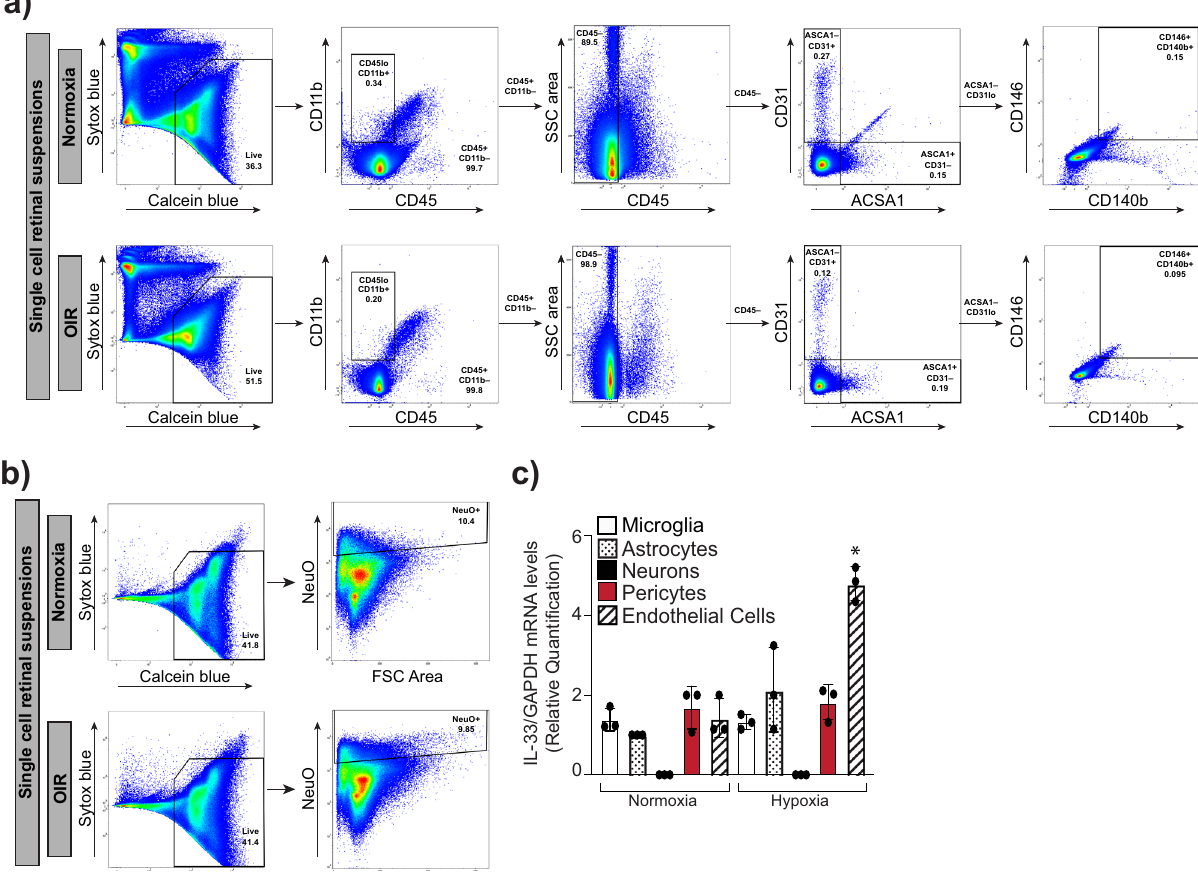
Fig. 4 Hypoxia-induced expression of IL-33 is mostly con fi ned to retinal endothelial cells. C57BL/6 mice pups were exposed to OIR and at P15 eyes from pups in normoxia or OIR were enucleated, retinas isolated, minced, digested and single cell retinal suspension were prepared in FACS buffer. The retinal cells were fi rst incubated with indicated dyes and antibodies. After washings, the cells were resuspended into sorting buffer, added SYTOX blue and subjected to FACS analysis. a Live cells from both normoxia and P15 were gated as calcein blue positive cells. CD11b positive and CD45 low cells were gated as microglia. CD31 positive and ACSA1 negative cells were gated endothelial cells. ACSA1 positive and CD31 negative cells are gated as astrocytes. CD146 positive and CD140b positive cells are gated as pericytes. b Calcein blue positive cells from both normoxia and OIR were gated as live cells and the NeuO + cells were gated as neurons. c Total cellular RNA was isolated from all the sorted cells and analyzed for IL-33 and GAPDH mRNA levels by QRT- PCR. The bar graphs show the quantitative analysis of three independent experiments ( n = 6 animals/group/experiment), expressed as Mean ± SD. * P < 0.05 vs